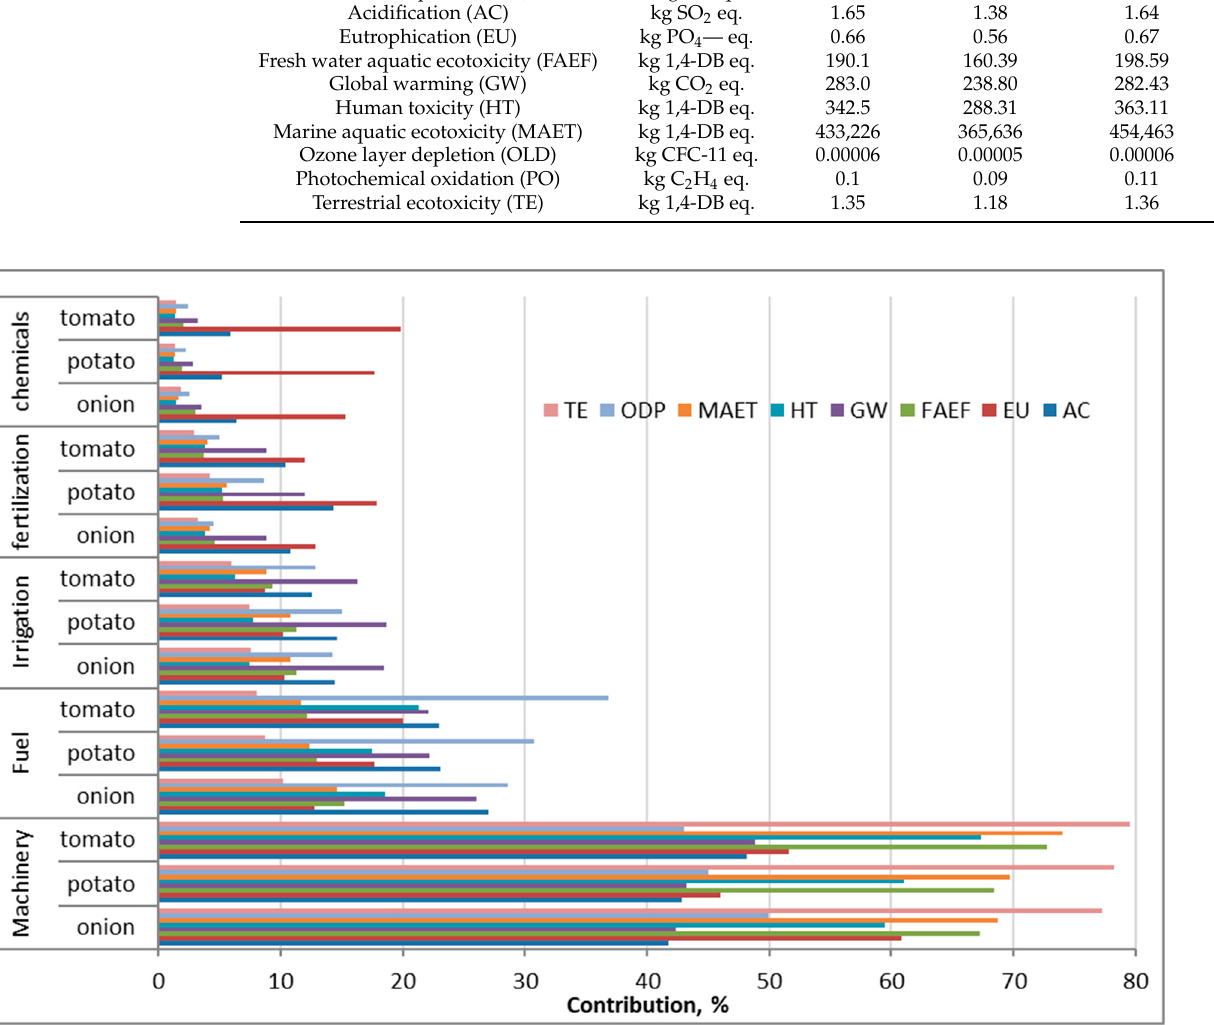
Figure 5. The contribution of individual inputs on the studied impact